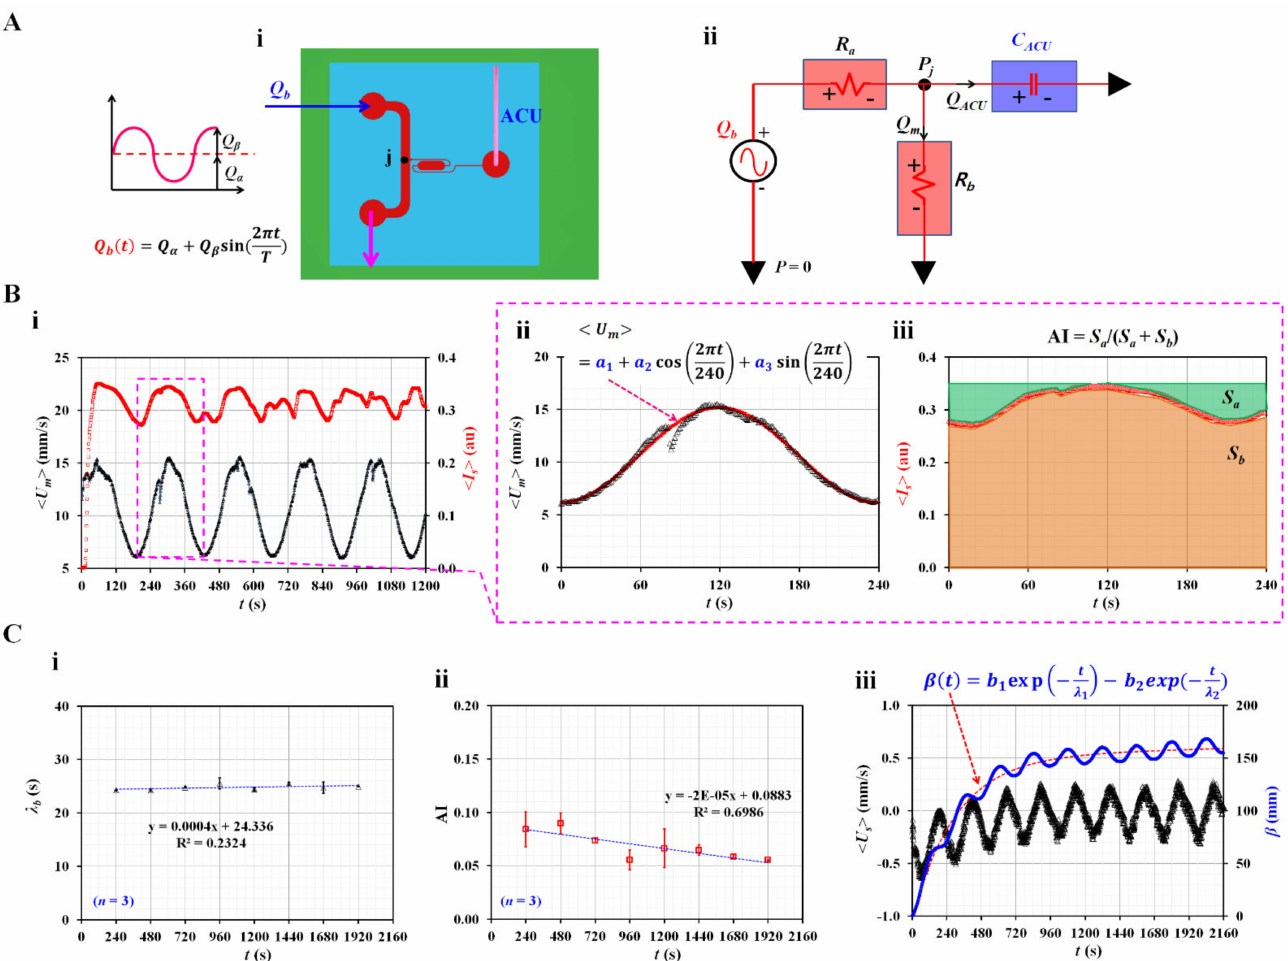
Figure 2. Mathematical representation of three rheological properties in terms of discrete fluidic circuit model. ( A ) Mathematical representation of microfluidic channels. ( i ) A top view of the microfluidic device. Blood flow rate set to pulsatile pattern. ( ii ) Mathematical representation of mi- crofluidic circuit. A discrete fluidic circuit model consisted of flow rate source ( Q b ), fluidic resistance ( R a , R b ), and compliance ( C ACU ). ( B ) Quantification of time constant ( λ b ) and RBC aggregation index (AI). ( i ) Temporal variations of < U m > and < I s >. ( ii ) A curve-fitting procedure of < U m > for single period. The < U m > was then assumed as < U m > = a 1 + a 2 cos(2 π t /240) + a 3 sin(2 π t /240). ( iii ) Temporal variations of < I s > for single period. Based on temporal variations of < I s >, two parameters ( S a , S b ) were (cid:82) T (cid:82) T − < I s ( t ) > ) dt , and S < I s ( t ) > dt , respectively. RBC aggrega- ( < I s > calculated as S a = max b = 0 0 tion index (AI) was then obtained as AI = S a /( S a + S b ). ( C ) Variation of three rheological properties at intervals of period. ( i ) Variation of λ b over period. ( ii ) Variations of AI over period. ( iii ) Temporal (cid:82) < U s > dt ) , the β variations of < U s > and β . Based on the constitutive equation (i.e., P j = 1 C ACU (cid:82) < u s > dt . The β ( t ) was then assumed as as new pressure-related variable was defined as β = − β ( t ) = b 1 exp ( − t / λ 1 ) − b 2 exp ( − t / λ 2